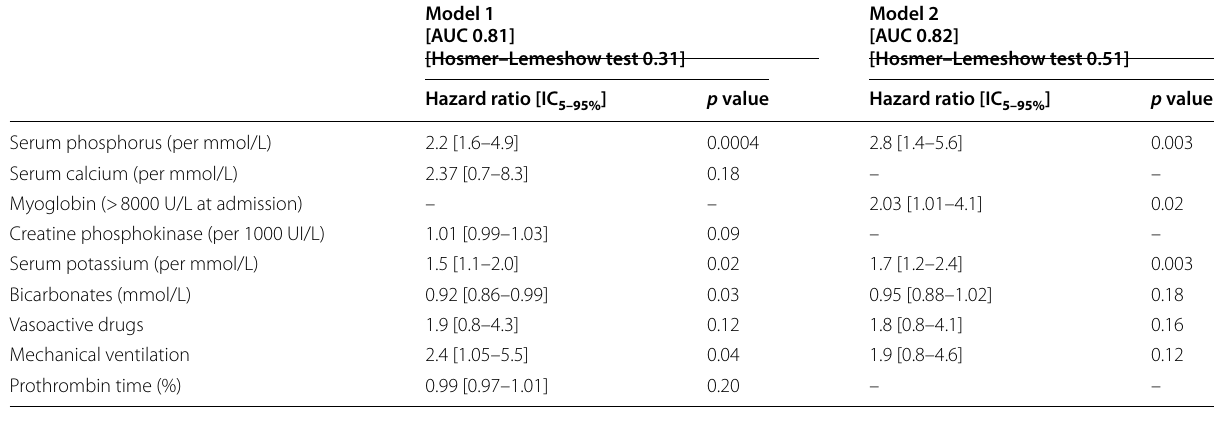
Table 2 Multivariate analysis of the predictive factors of KDIGO stage 2–3 acute kidney injury in patients with severe rhabdomyolysis